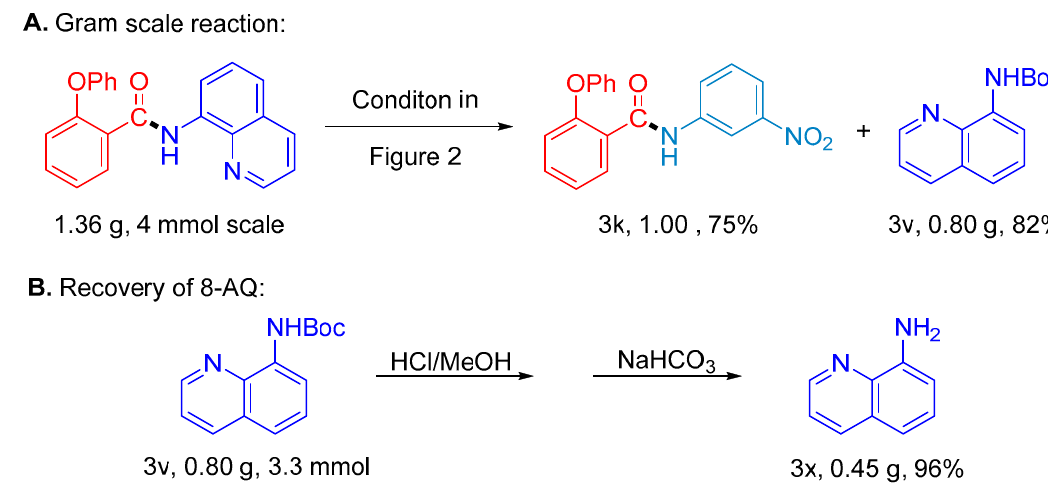
Figure 3. Scope of alkyl amines. a Reaction temperature 25 °C, b 80 °C.